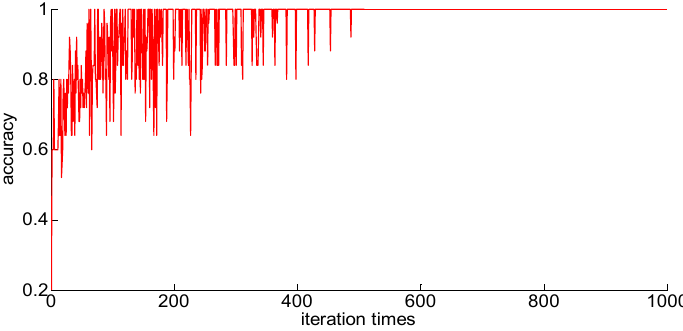
Figure 16. Seventy-five training samples of the neural network.